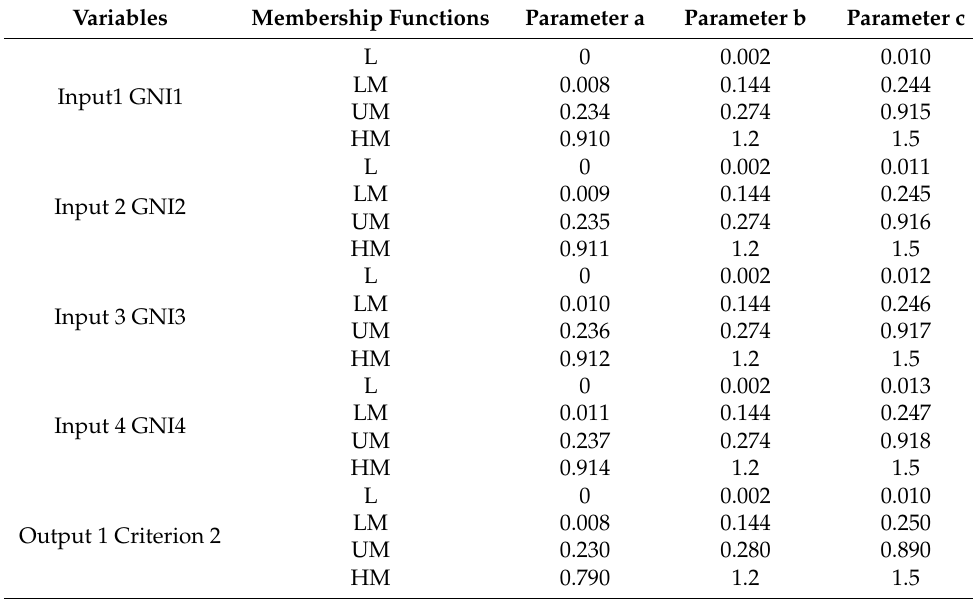
Table 12. Type-1 FIS: Input-Output membership